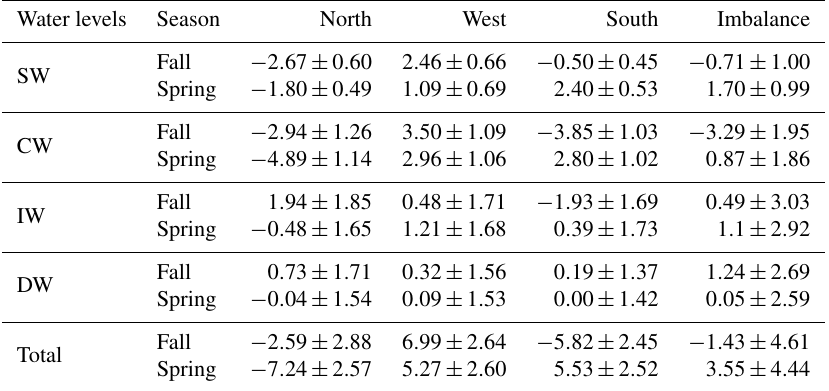
Table 4. Mass transports with their errors (Sv) for SW, CW, IW and DW across the north, west and south transects for both seasons. Positive– negative values indicate outward–inward transports. The last row is the integrated transport for the entire water column in each transect, while the fourth column summarizes the imbalances in mass transport for both seasons.